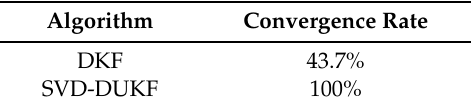
Table 3. The success convergence rate of the DUKF and the singular value decomposition (SVD)-DUKF in 1000